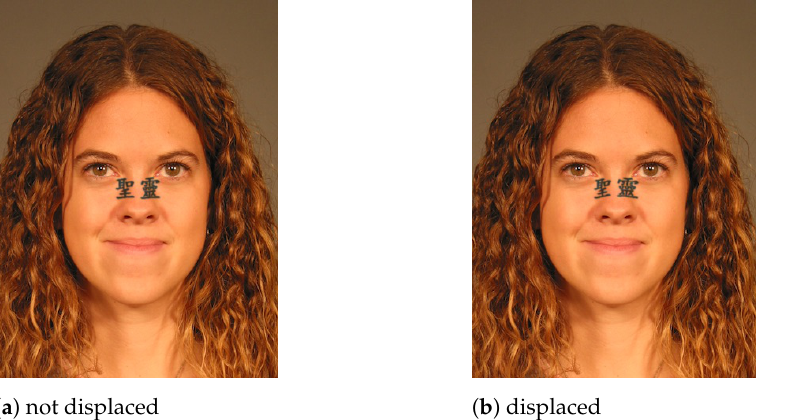
Figure 7. Facial images with tattoos ( a ) before and ( b ) after applying the displacement technique. For ( b ), the tattoo is blended around the anticipated 3D shape of the nose. Best viewed in electronic format (zoomed